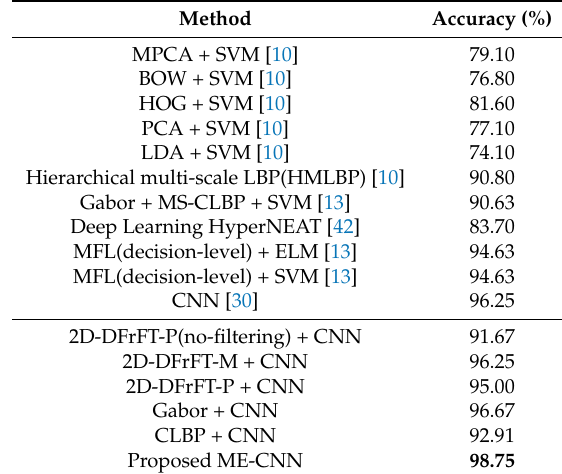
Table 5. Comparison of classification accuracy (%) with some state-of-the-art methods for the BCCT200-resize